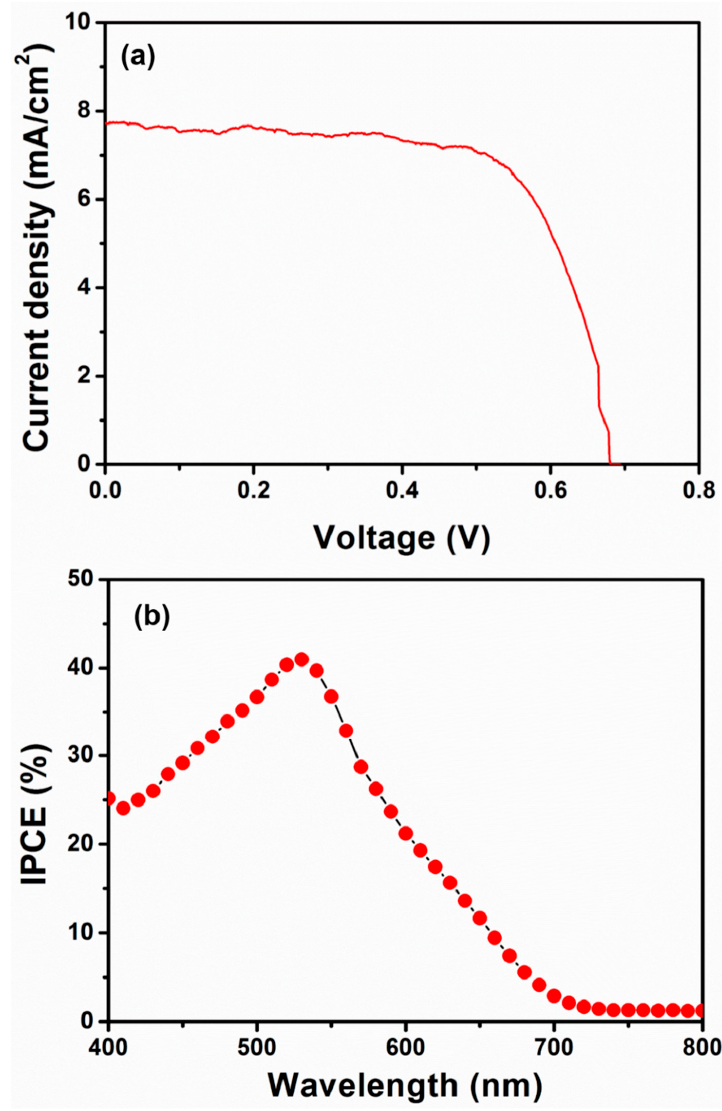
Figure 7. Typical ( a ) current–voltage (J–V) and ( b ) incident photon to current efficiency